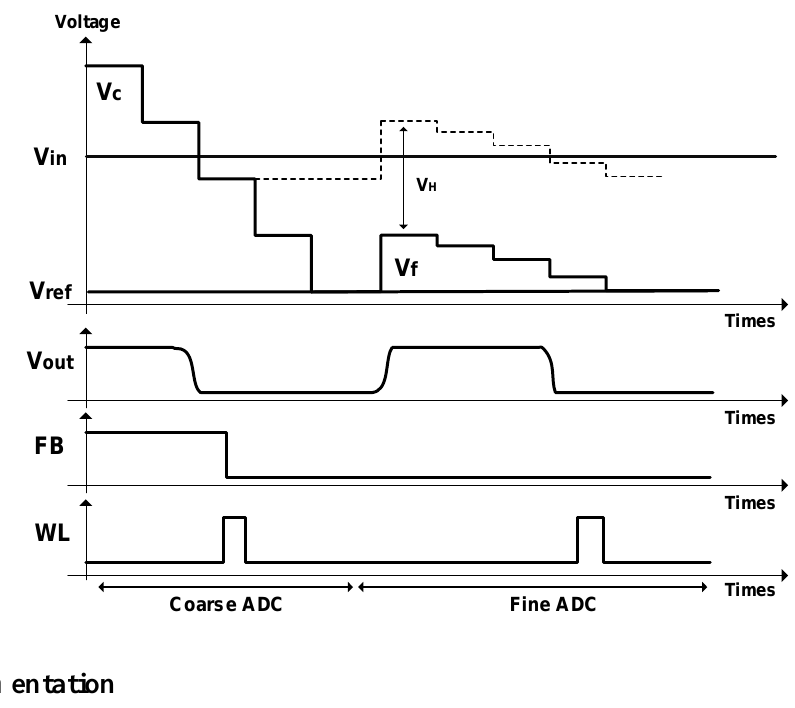
Figure 4. Timing diagram of the TS SS ADC ( design example for 4-bit TS SS ADC: 2-bit coarse ADC and 2-bit fine